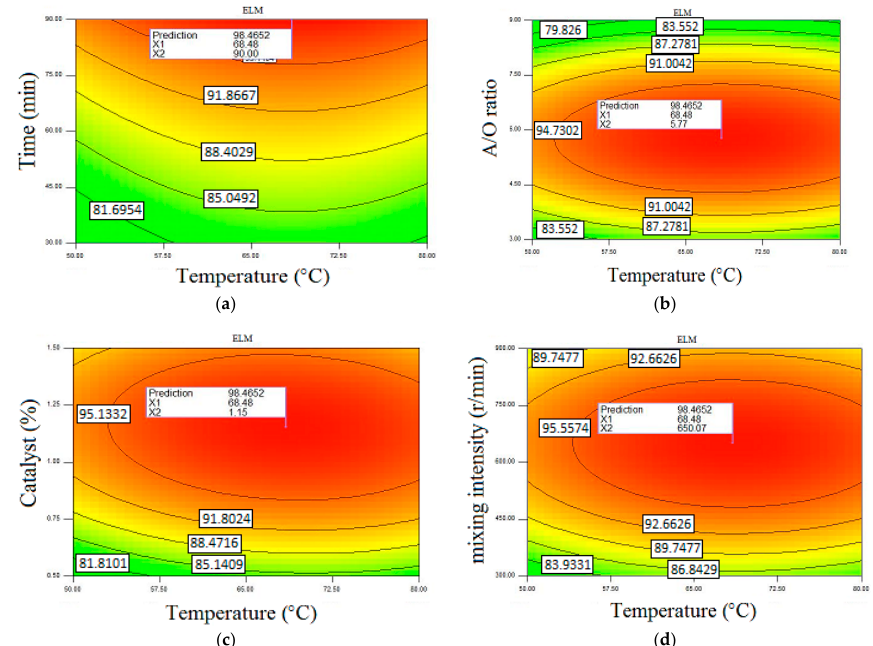
Figure 8. The optimization condition of ethyl ester production in the case of using the RSM-ELM method. ( a ) Response surface based on time (min) and temperature (°C); ( b ) response surface based on A/O and temperature (°C); ( c ) response surface based on catalyst (wt. %) ratio and temperature (°C); and ( d ) response surface based on mixing intensity (r/min) and temperature (°C).